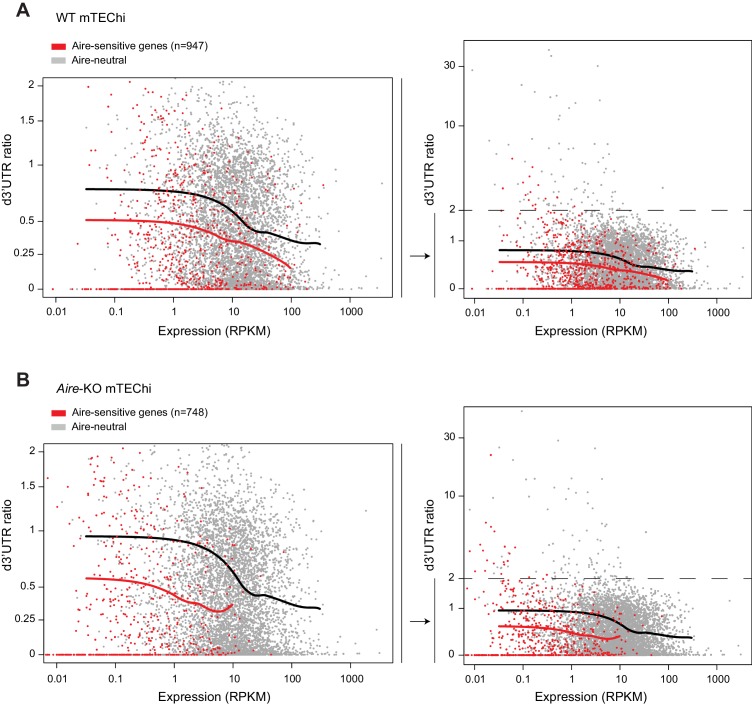
Scatterplot of d3’UTR ratio versus gene expression.d3’UTR ratios in WT (A) and Aire-KO mTEChi (B) of Aire-sensitive genes and of all Aire-neutral genes, restricted to values between 0 and 2 (Left) or including all values (Right), asinh scale. Loess-fitted curves are represented for the Aire-sensitive (red) and the Aire-neutral genes (black).